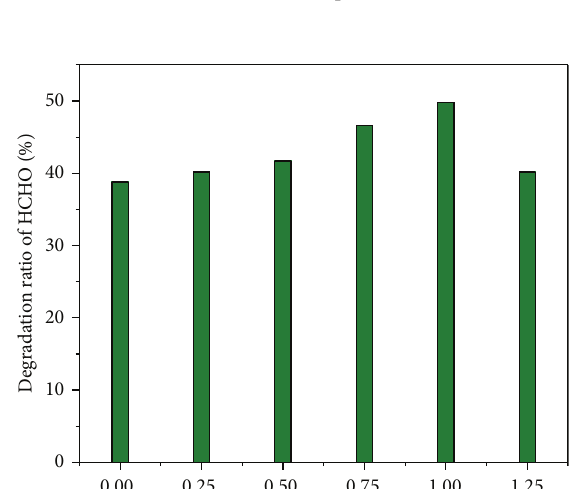
Figure 4: EDS spectra.